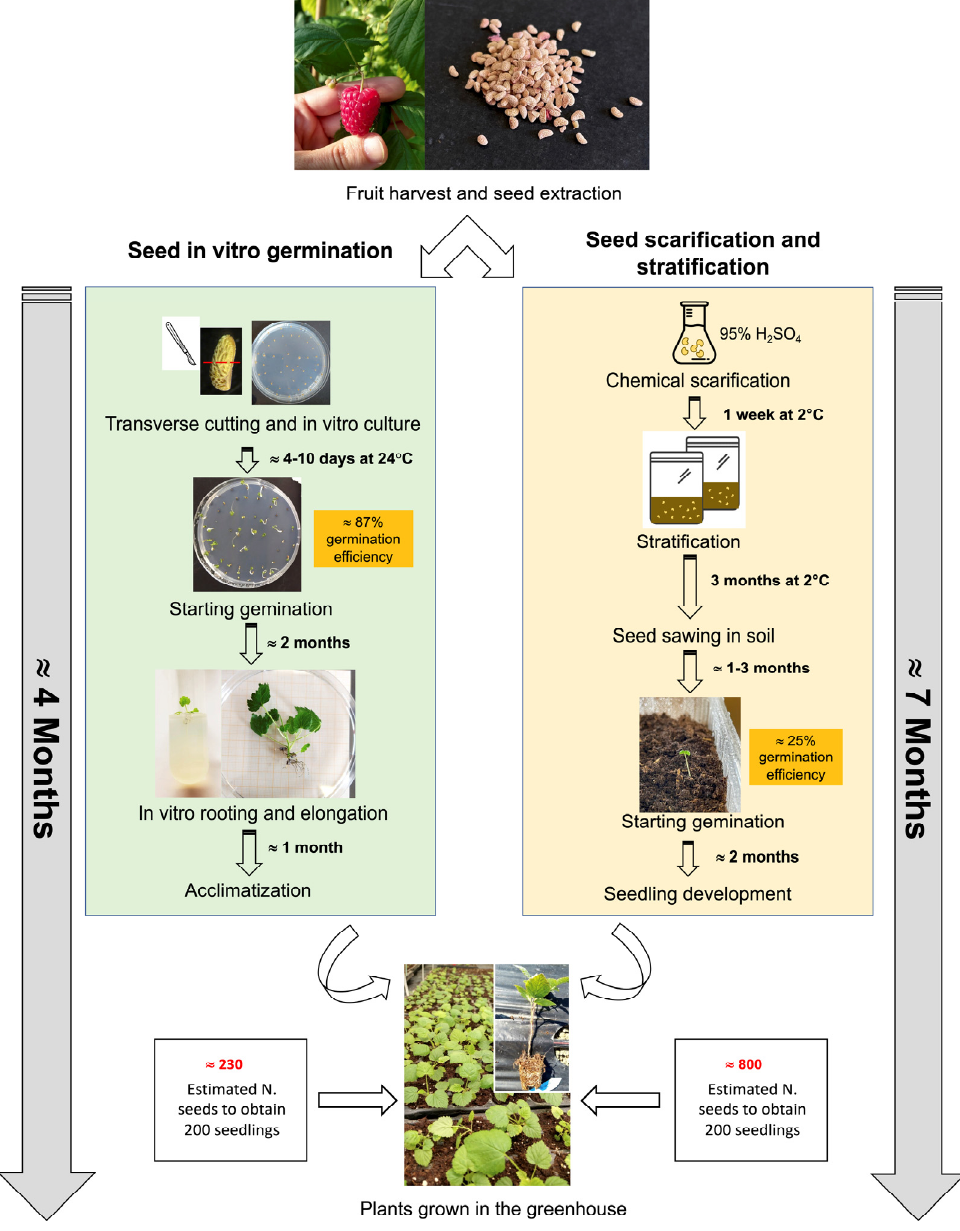
Figure 7. Schematical drawing of the steps required to obtain well-established seedlings of raspberry by following the optimized in vitro germination protocol in comparison with the scarification and stratification method used in this